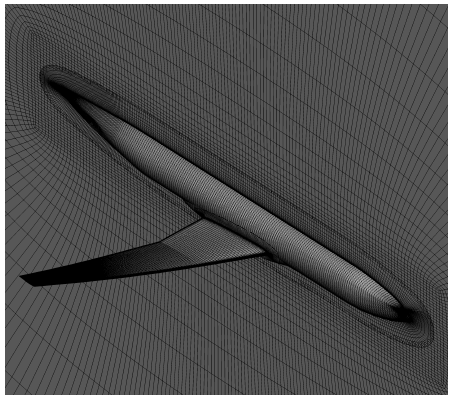
Figure 6. Common research model